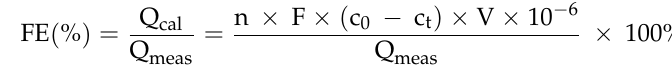
Table 3. Faraday efficiency of electrochemical oxidation reaction during desorption process of CoHCF thin film.